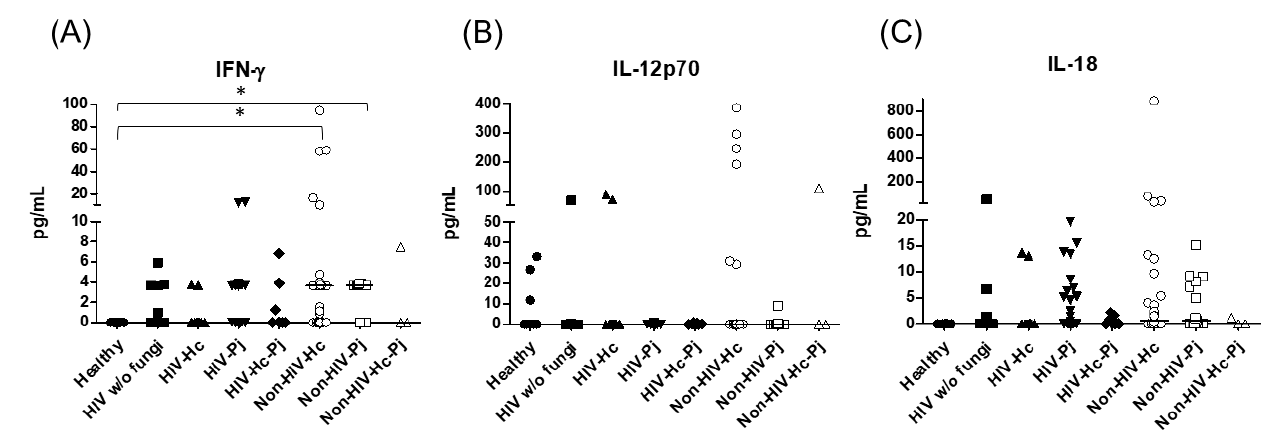
Figure 4. Determination of cytokines of the IFN- γ /IL-12 axis. IFN- γ , IL-12p70, and IL-18 were detected by a cytometric bead assay in the BAL samples of hospitalized patients; results were obtained in pg/mL. Median values are shown for ( A ) IFN- γ , ( B ) IL-12p70, and ( C ) IL-18. * p < 0.05. Regarding the proinflammatory cytokines of the IL-17/IL-23 axis, the involvement of IL-6, IL-17A, and IL-23 was analyzed, with a significant difference in IL-17A median values among all groups ( p = 0.0118) (Figure 5). For IL-6 and IL-17A, it is remarkable that the non-HIV patient groups had higher values than the other groups (Figure 5). Among the cytokines related to granuloma formation, analysis of IL-33, IL-5, and IL-13 in the BAL samples showed significant differences in IL-33 and IL-13 among all groups ( p = 0.0201 and p = 0.0018, respectively). Concerning IL-5, most non-HIV patient groups had high medians; however, no differences were found in the individual analyses of each group. In general, several patient groups showed decreased IL-13 median values compared with the control groups (Figure 6).